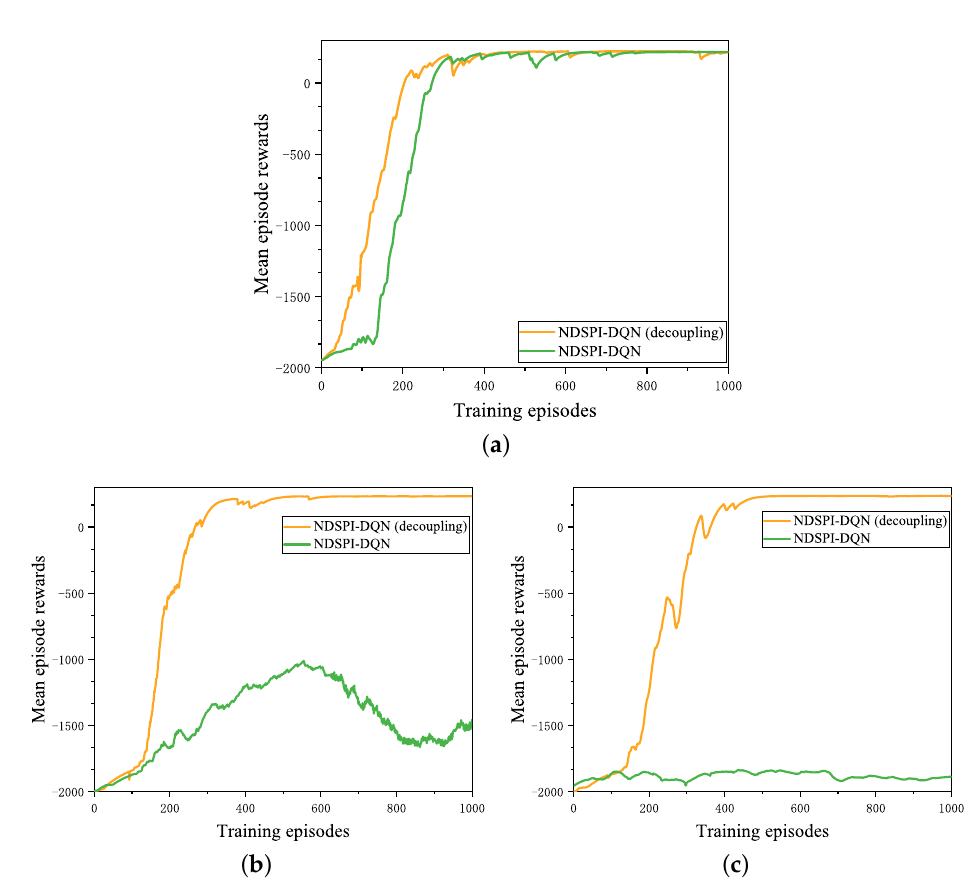
Figure 6. Mean rewards versus training episodes in different scenarios. ( a – c ) show results for scenario 2 (80 hosts), scenario 3 (120 hosts) and scenario 4 (150 hosts), respectively.